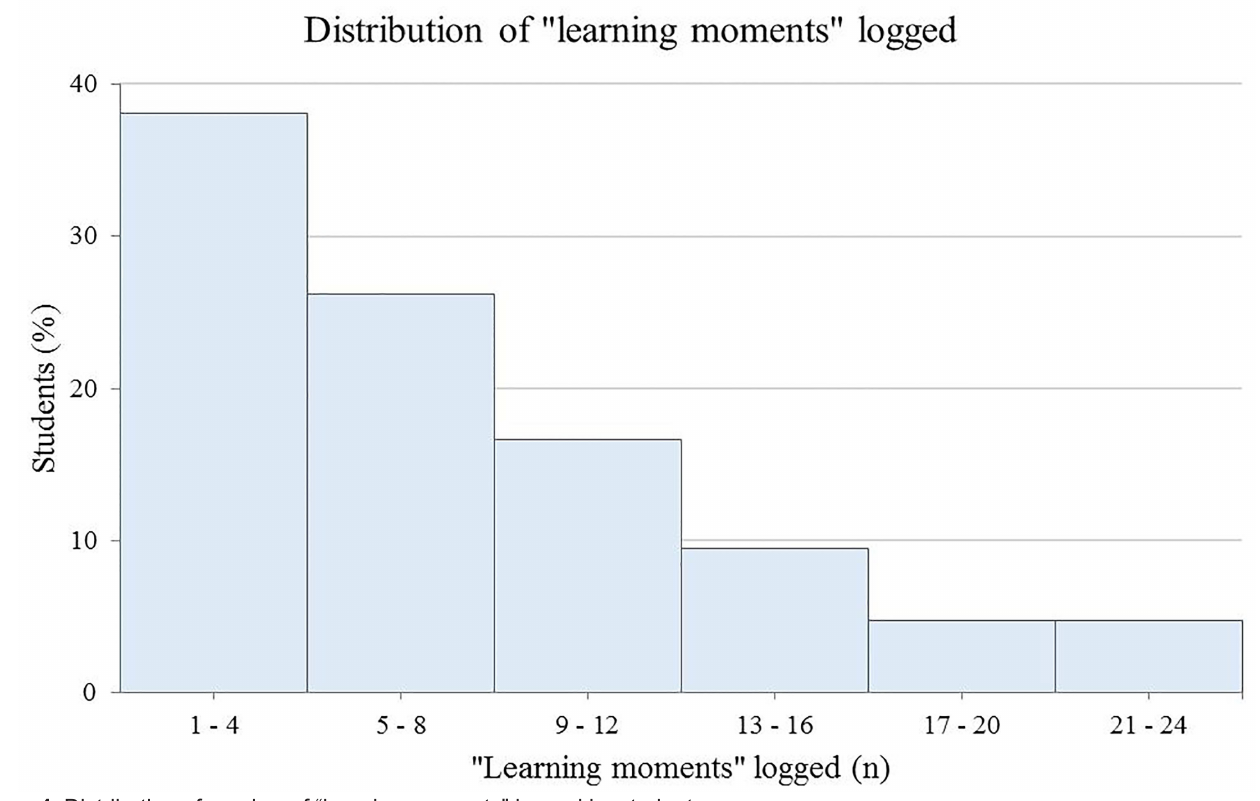
Figure 4. Distribution of number of “learning moments” logged by